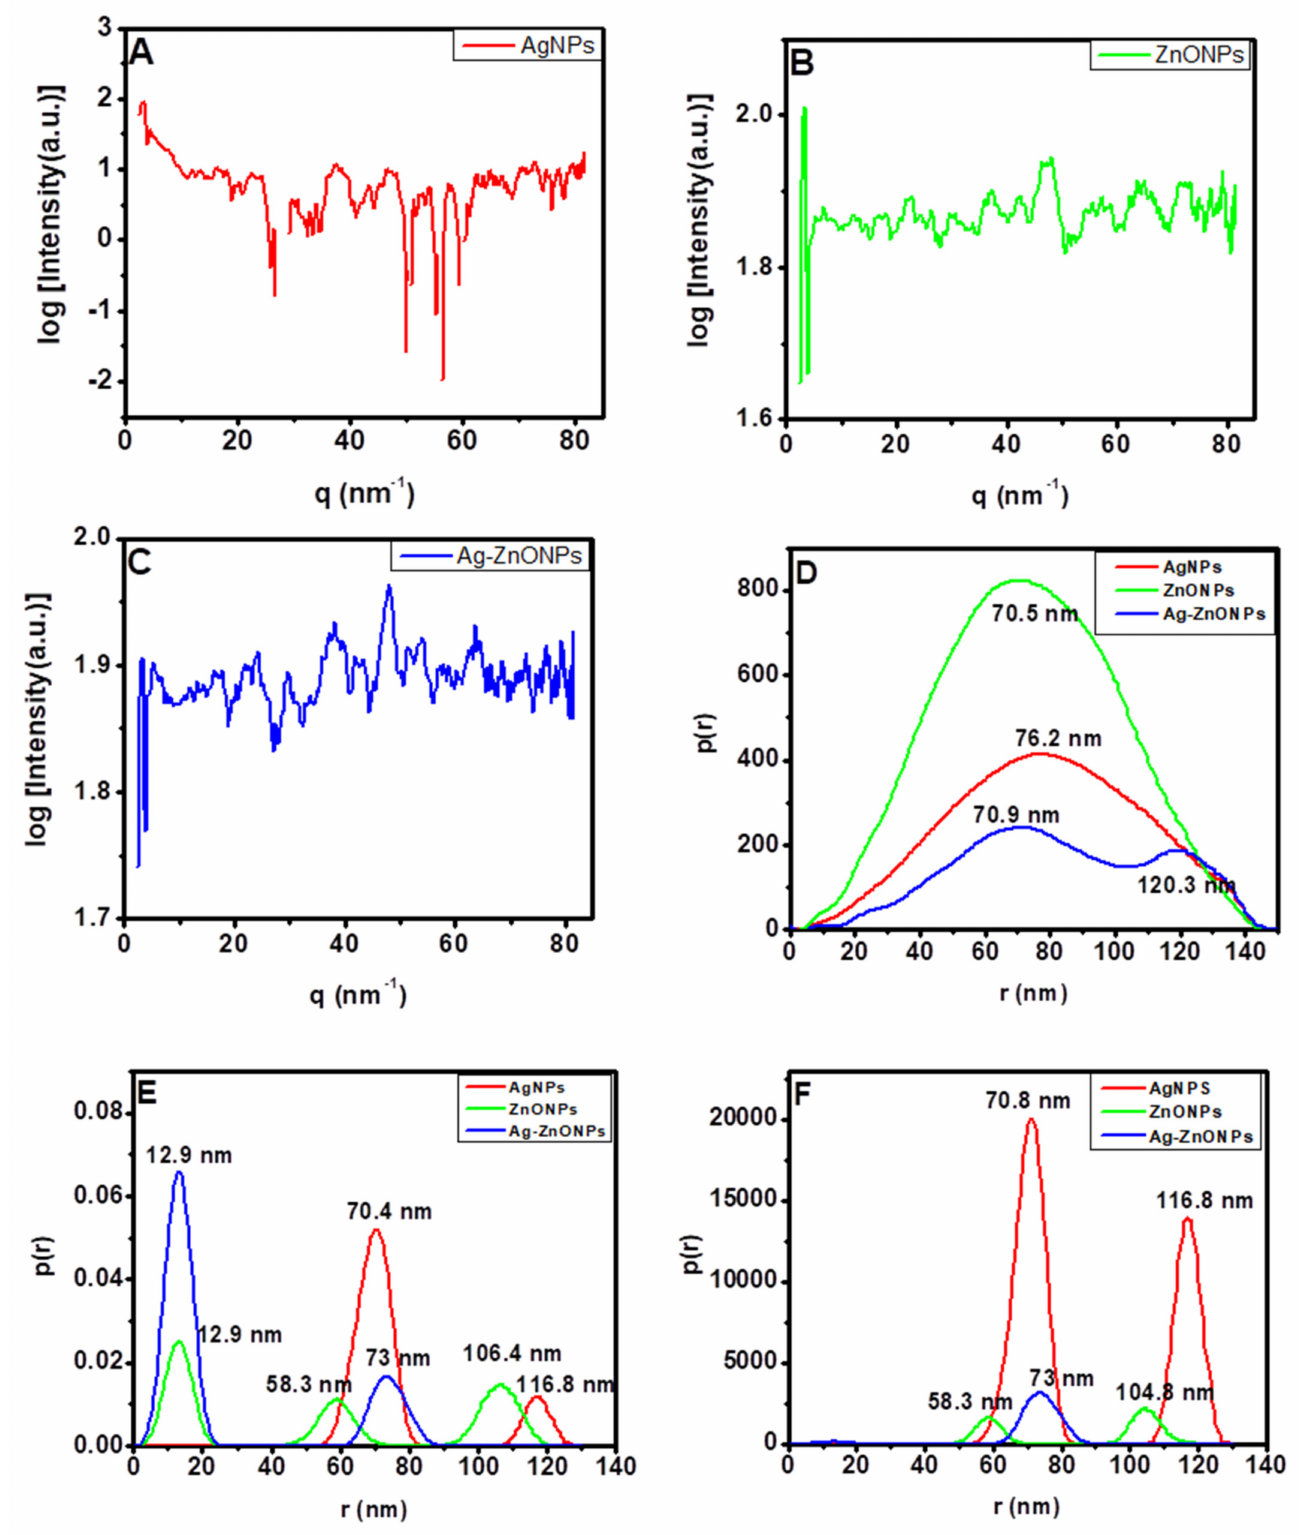
Figure 5. ( A – C ) Scattering vector SAXS spectra, ( D – F ) particle size distribution analysis of SAXS data. Graphs are presented for ( D ) pair-distance distribution function; ( E ) number-weighted size distribution; and ( F ) volume-weighted size distribution: AgNPs (red line), ZnONPs (green line), and Ag–ZnONPs (blue